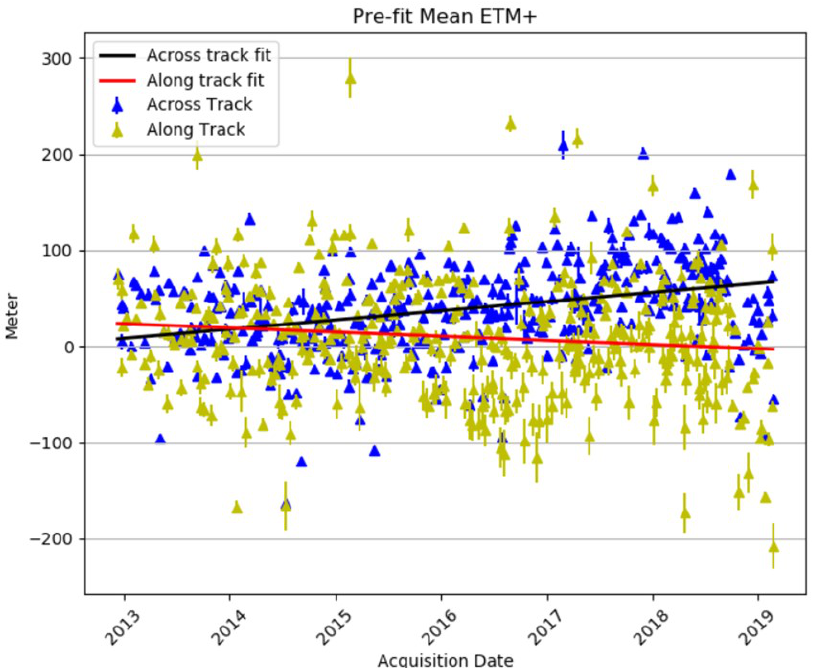
Figure 12. Geodetic accuracy for along and across track means prior to sensor alignment calibration. An upward trend in the across track direction is shown by the solid black line. The solid black line in Figure 12 shows the trend in the across track mean, while the solid red line shows the trend in the along track mean directions. This black line and its trend that the sensor alignment calibration attempts to remove, flattening out the trend present in the across track direction. The small individual bars on each scene’s results give the standard deviation of the measured means. The sensor alignment algorithm deter- mines a set of roll, pitch, and yaw interior orientation parameters for each scene’s geodetic accuracy results. It uses a moving average window over these individual attitude align-